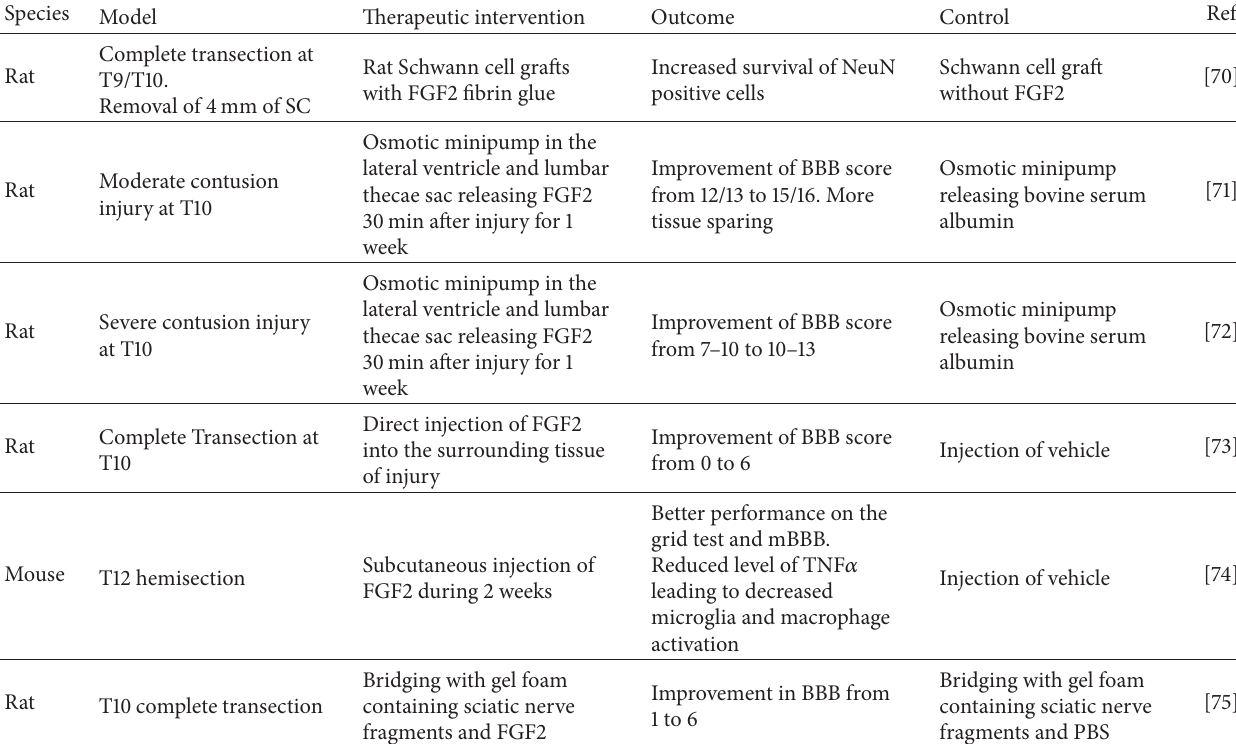
Table 2: Different strategies to promote regeneration or neuroprotection using